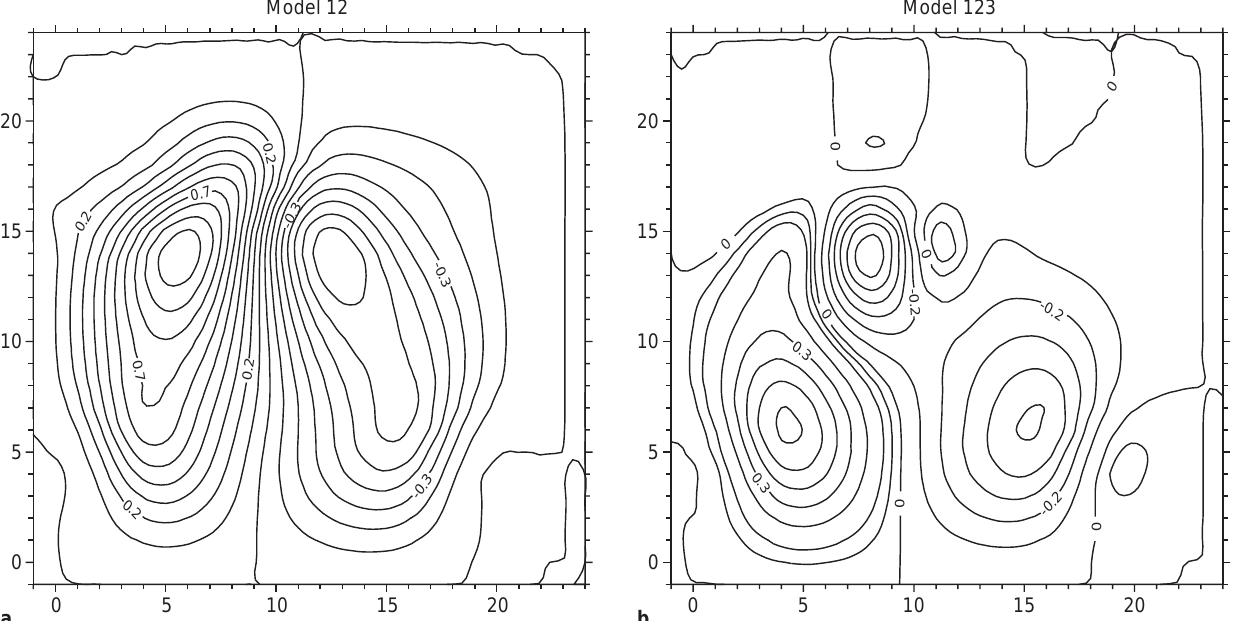
Fig. 2a, b. Model convection pattern for a 2-cell and b